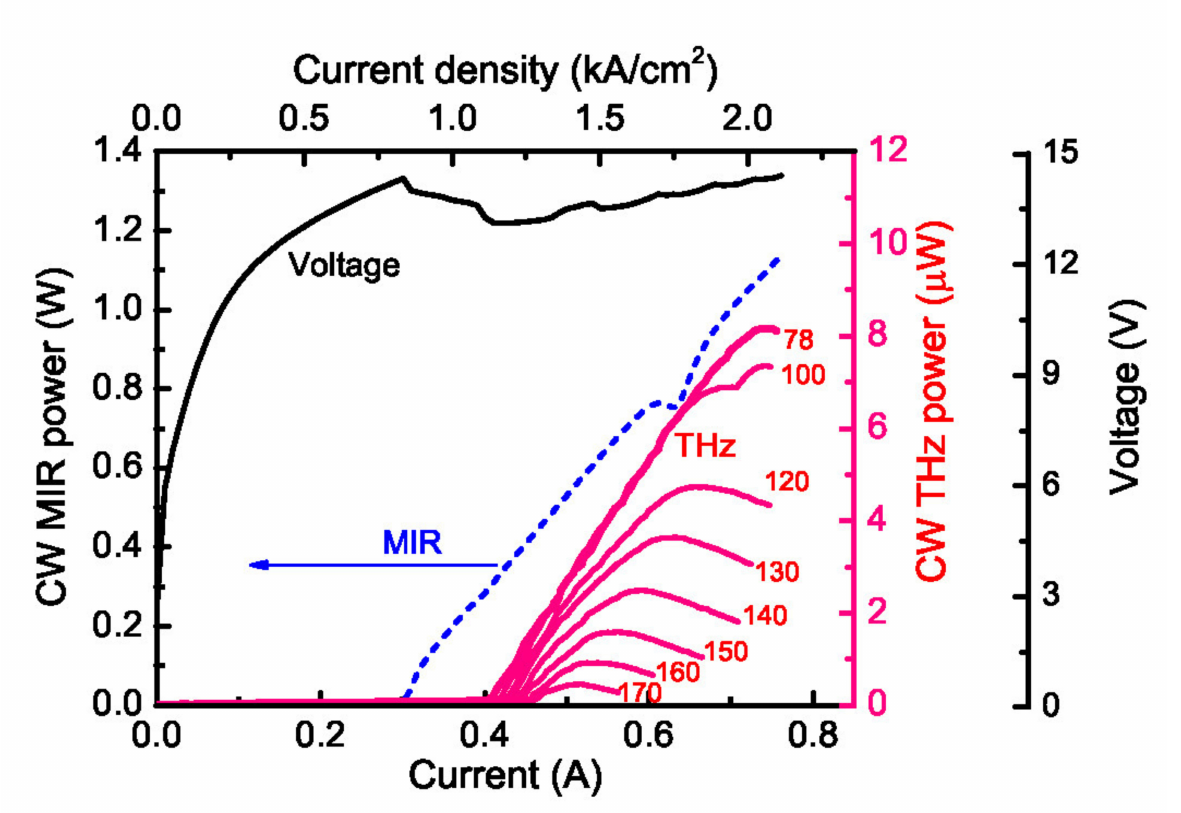
Figure 2. Current–voltage and light–current characteristics of the mid-infrared pumps at 78 K and THz DFG at various temperatures, for the device operated in continuous-wave (CW)